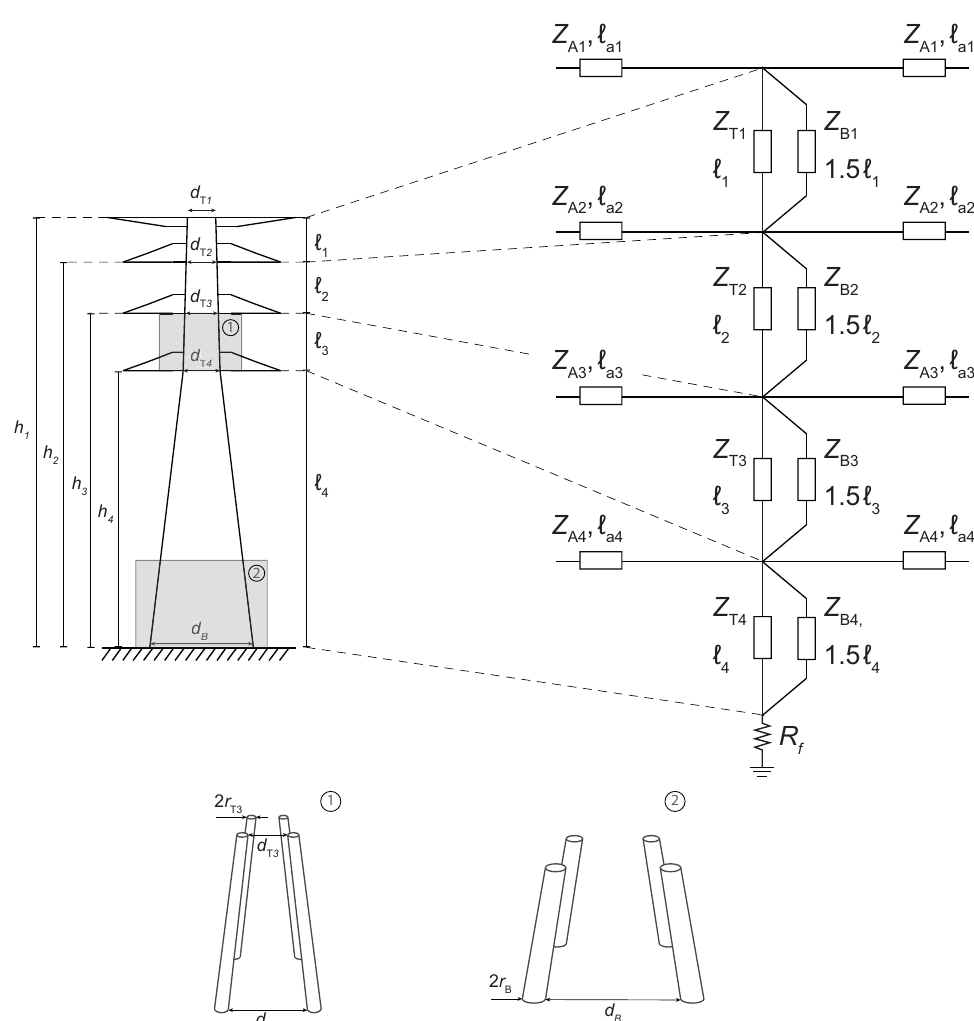
Figure 9. Equivalent circuit proposed by Hara and Yamamoto [84], partitioning the tower in N s = 4 sections; suitable transmission lines account for the tower main body ( Z T ( Z B , β 0 ), and crossarms ( Z A , β 0 i i